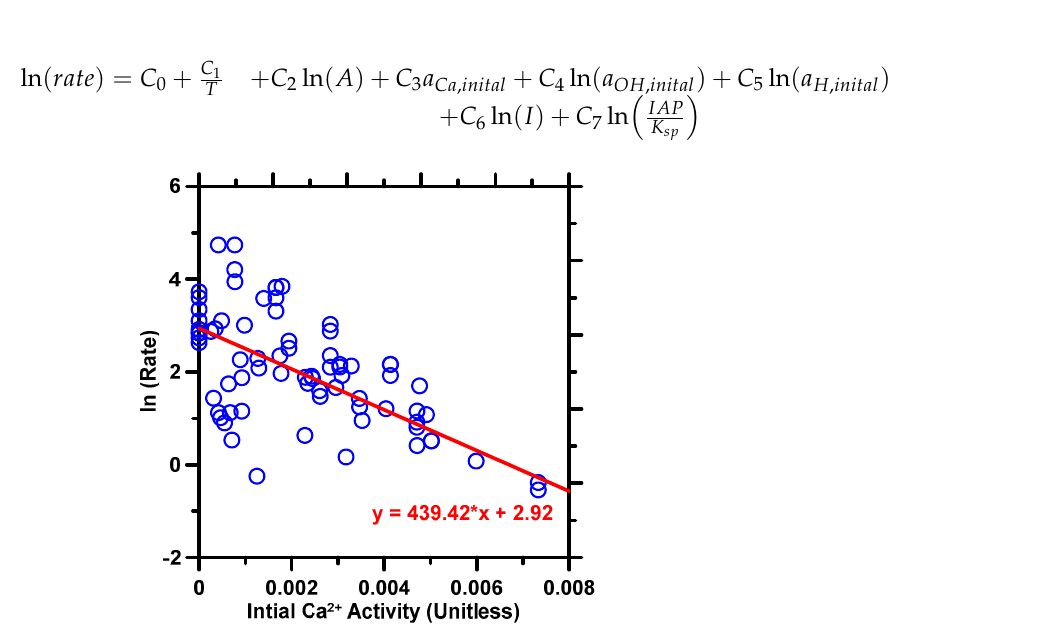
Figure 4. The dissolution rate of C 3 S, expressed in terms of natural logarithm, against the ion activity of Ca 2+ in solvents. The red line indicates the linear correlation.